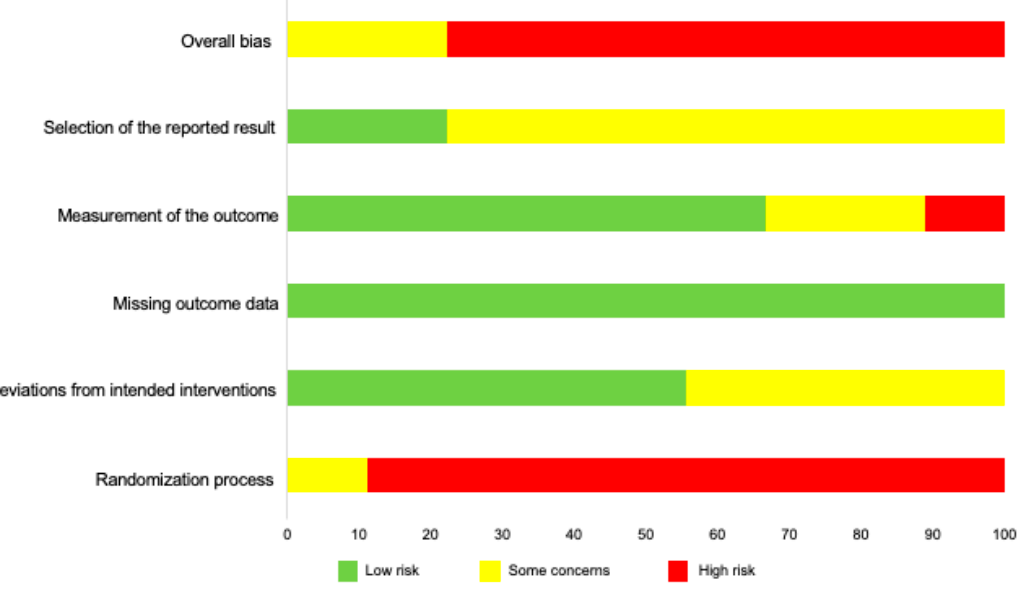
Figure 5. Risk of bias across studies focusing on the liver, in both mice and humans. This figure displays the relative percentages of intention-to-treat data of assessed risk of bias in the liver in human and mouse studies. The overall bias was determined using five categories: Selection of the reported result, measurement of the reported outcome, missing outcome data, deviations from intended interventions, and randomization process. Risk was determined as “low risk,” “some concerns,” or “high risk,” based on the Cochrane RoB 2.0 tool algorithm. The data for this figure included nine articles.